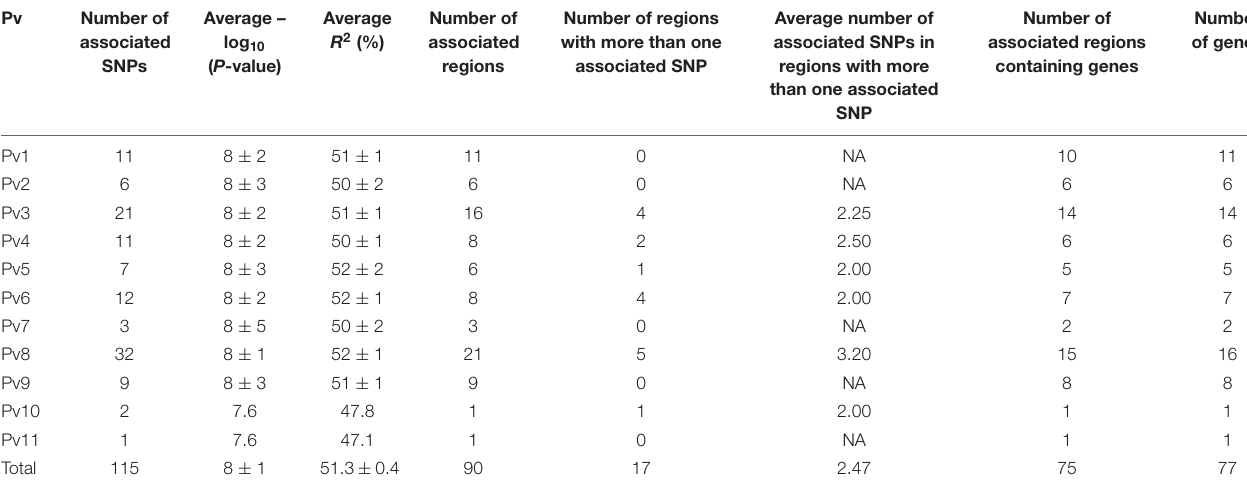
Given are results of a mixed linear model with a centered IBS kinship matrix as a random effect, and the first two PCoA axes scores ( Figure 2 ) as covariates. Regions are defined here as overlapping 1,000 bp sections that flanked associated markers. Potential candidate genes were identified within the 1,000 bp section flanking each